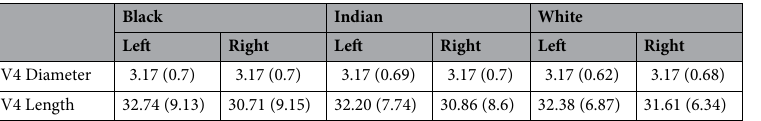
Black Indian White Left Right Left Right